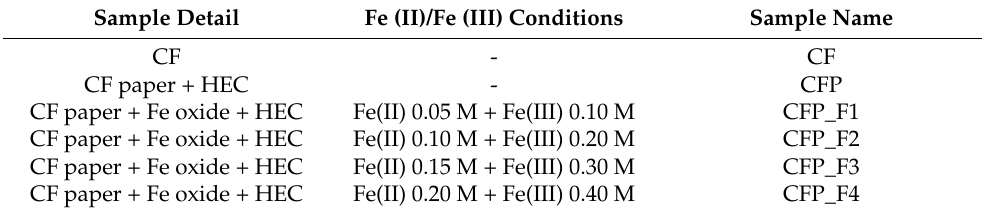
Table 1. The fabrication detail and of all the fabricated